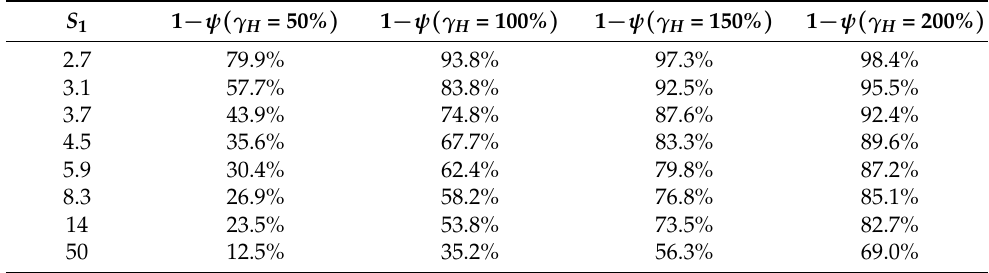
Table 2. Percentage reduction of the ψ function with the shear strain for different values of the primary shape factor.